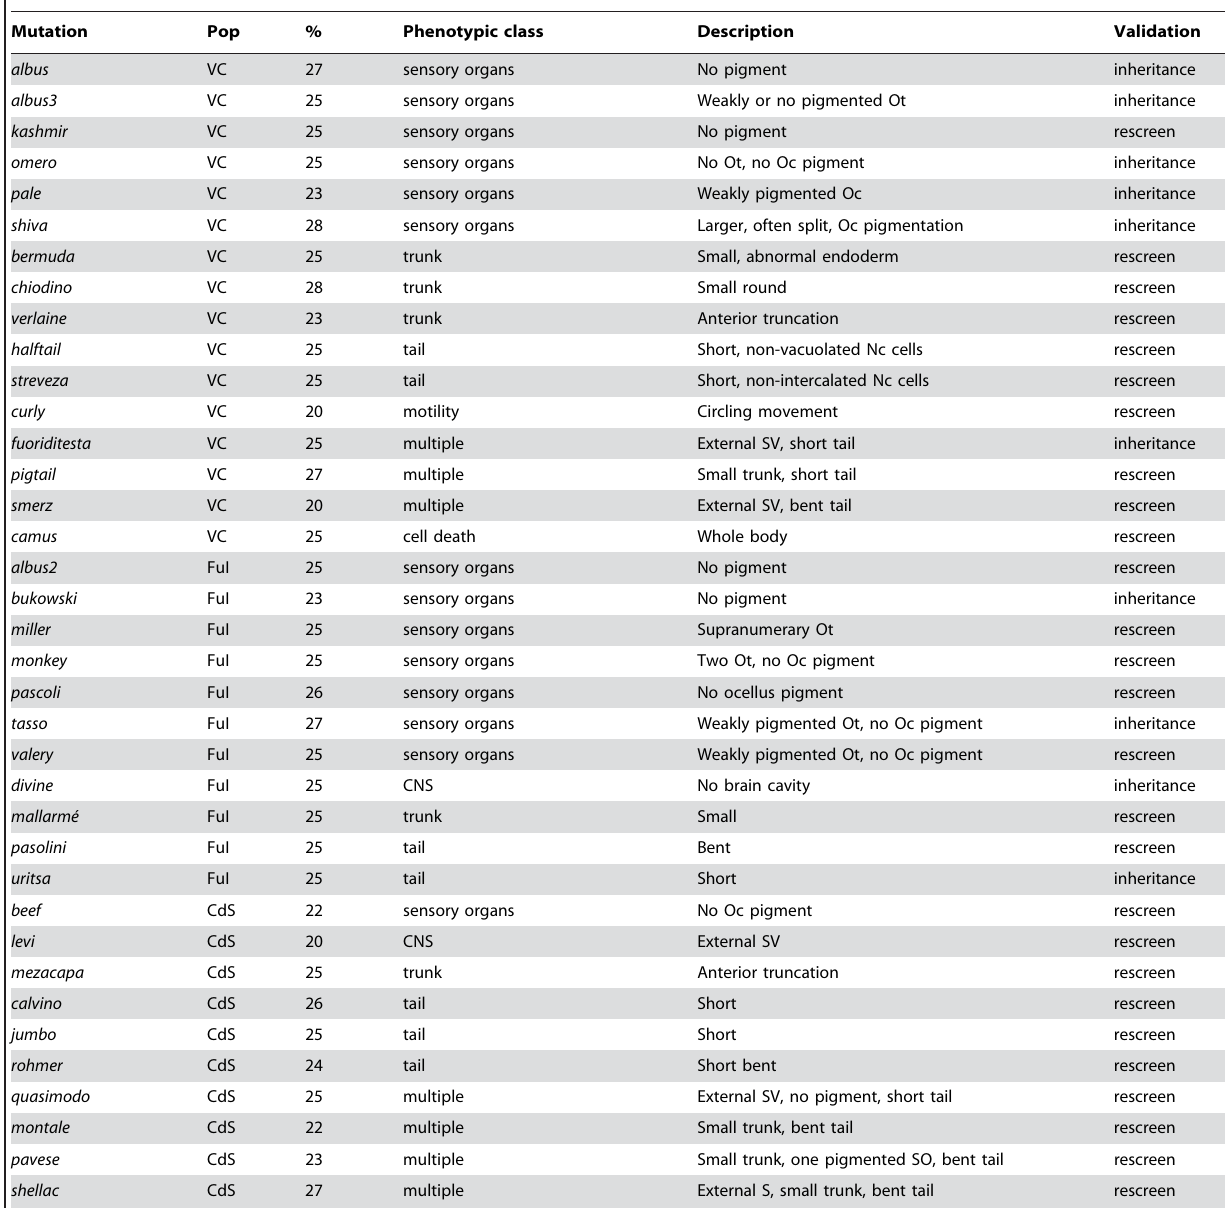
Table 2. List of naturally occurring mutations identified during the screening.